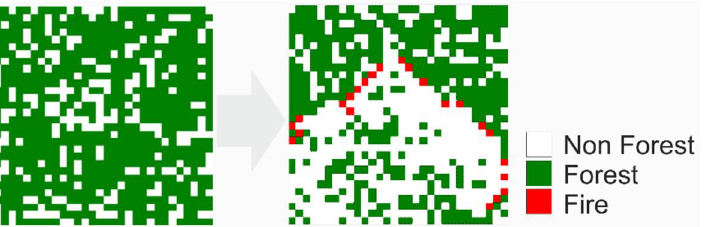
Figure 2. Fire model according to Drossel–Schwabl. On the left is a representation of the cellular automaton, consisting of vegetation (green) and empty cells (white). On the right is the spread of a fire event (red). In this schematic visualization of a virtual landscape, one cell has the size of 20 m, and the total area is 30 × 30 cells.